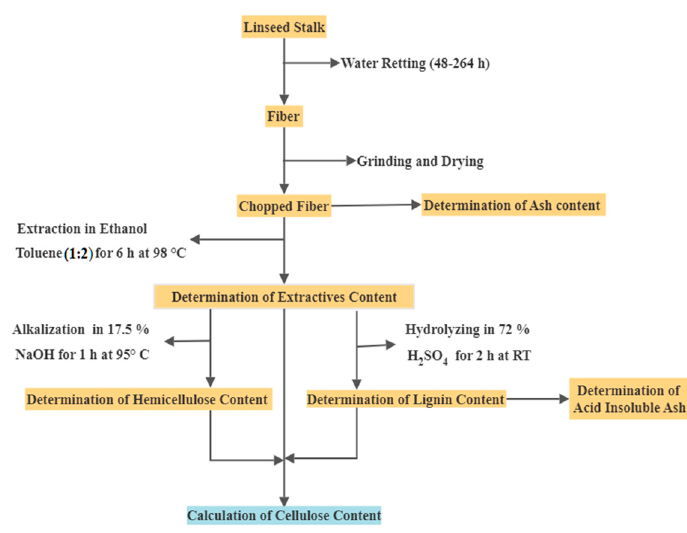
Figure 1. Flowchart of retting and chemical-composition analysis. Percentage amounts of non-cellulosic constituents ( wt .%) were calculated from the difference between initial ( w i ) and final ( w f) fiber weights, using the gravimetric method based on Equation (6) [50,51].